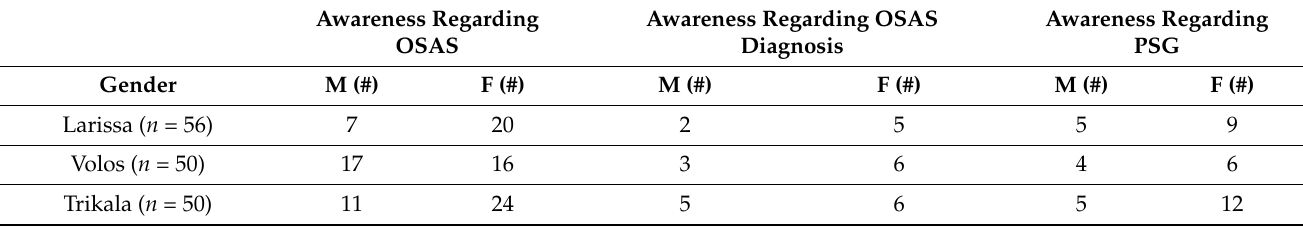
Table 3. Participants’ Awareness regarding OSAS, its diagnosis’ and PSG per insular